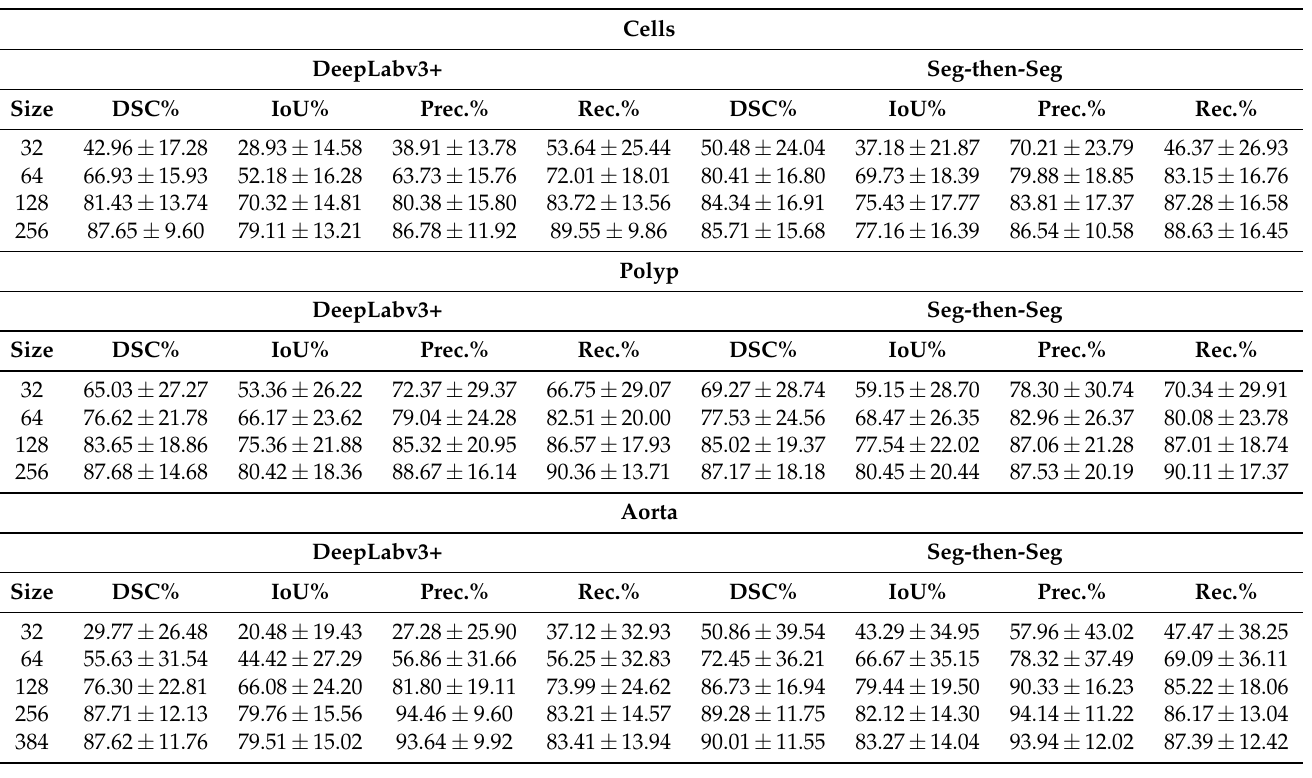
Table A3. The full results of each of our DeepLabv3+